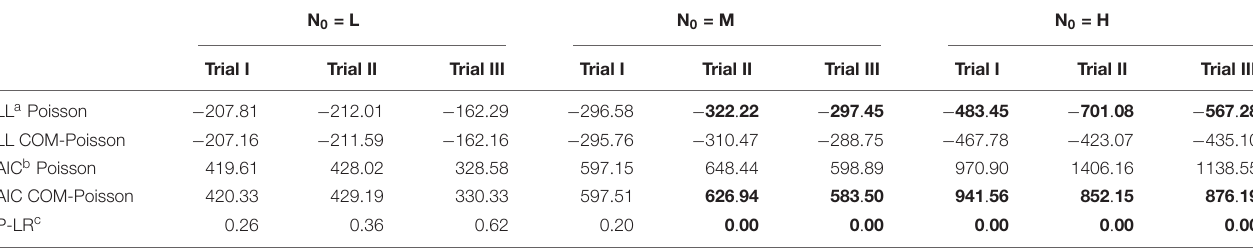
TABLE 3 | Log-likelihood value (LL), P of likelihood ratio test (P-LR) and Akaike information criterion (AIC) to determine the better-fitted distribution for L. monocytogenes observed survivors in each of the three osmotic non-thermal inactivation trials, starting with different initial cells (L, low inoculum; M, medium inoculum; H, high